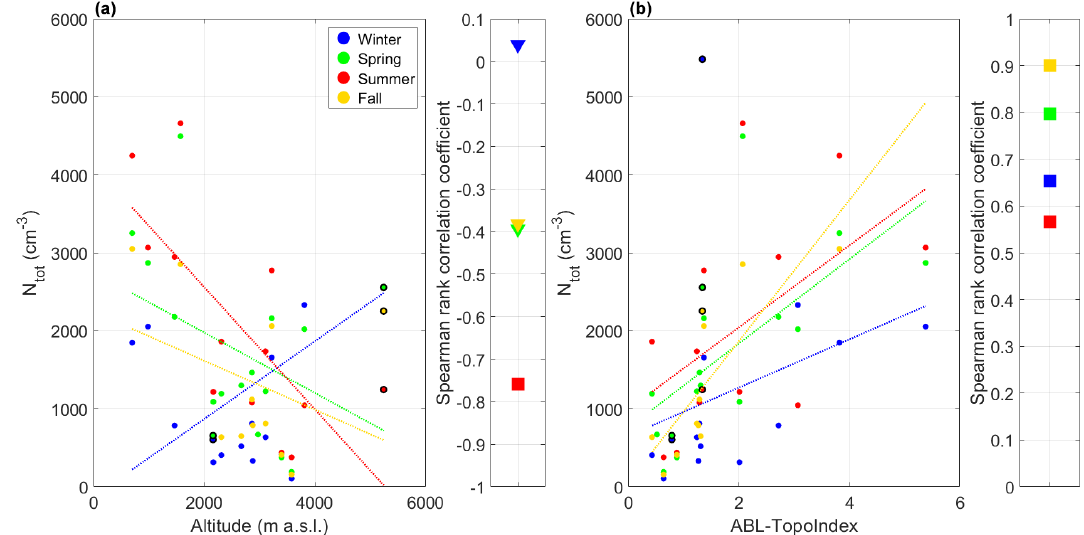
Figure 10. Connection between N tot and (a) the elevation of the mountain sites and (b) corresponding ABL-TopoIndex in each season. The linear fit between the two variables is shown in each case to further guide the eye, but the strength of the correlation is evaluated based on Spearman’s rank correlation coefficient. Statistically significant correlations at the 95% confidence level are represented by squares, while non-statistically significant correlations (at the 90% confidence level) are represented by triangles. Observations from RUN and CHC, the two mountains sites located in the Southern Hemisphere, are highlighted by the black circles in the scatter